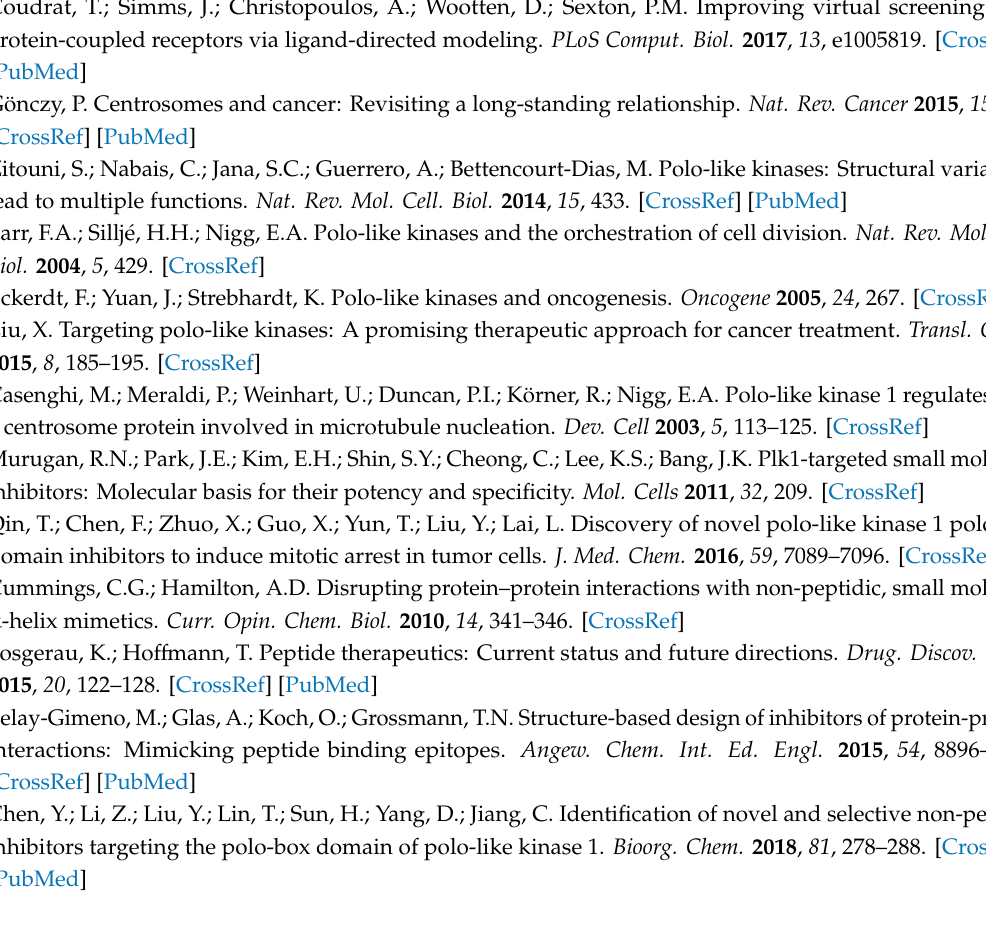
on the model. Figure S2: Key interactions of the 3,4-dichlorophenylalanine involved in stabilizing peptide 5 in the Table S1: Results of docking scores and IC 50 values of the 9 selected peptides. Table S2: Selectivity of peptide 5 against PLKs-PBD. Table S3: Sequences of 15 active